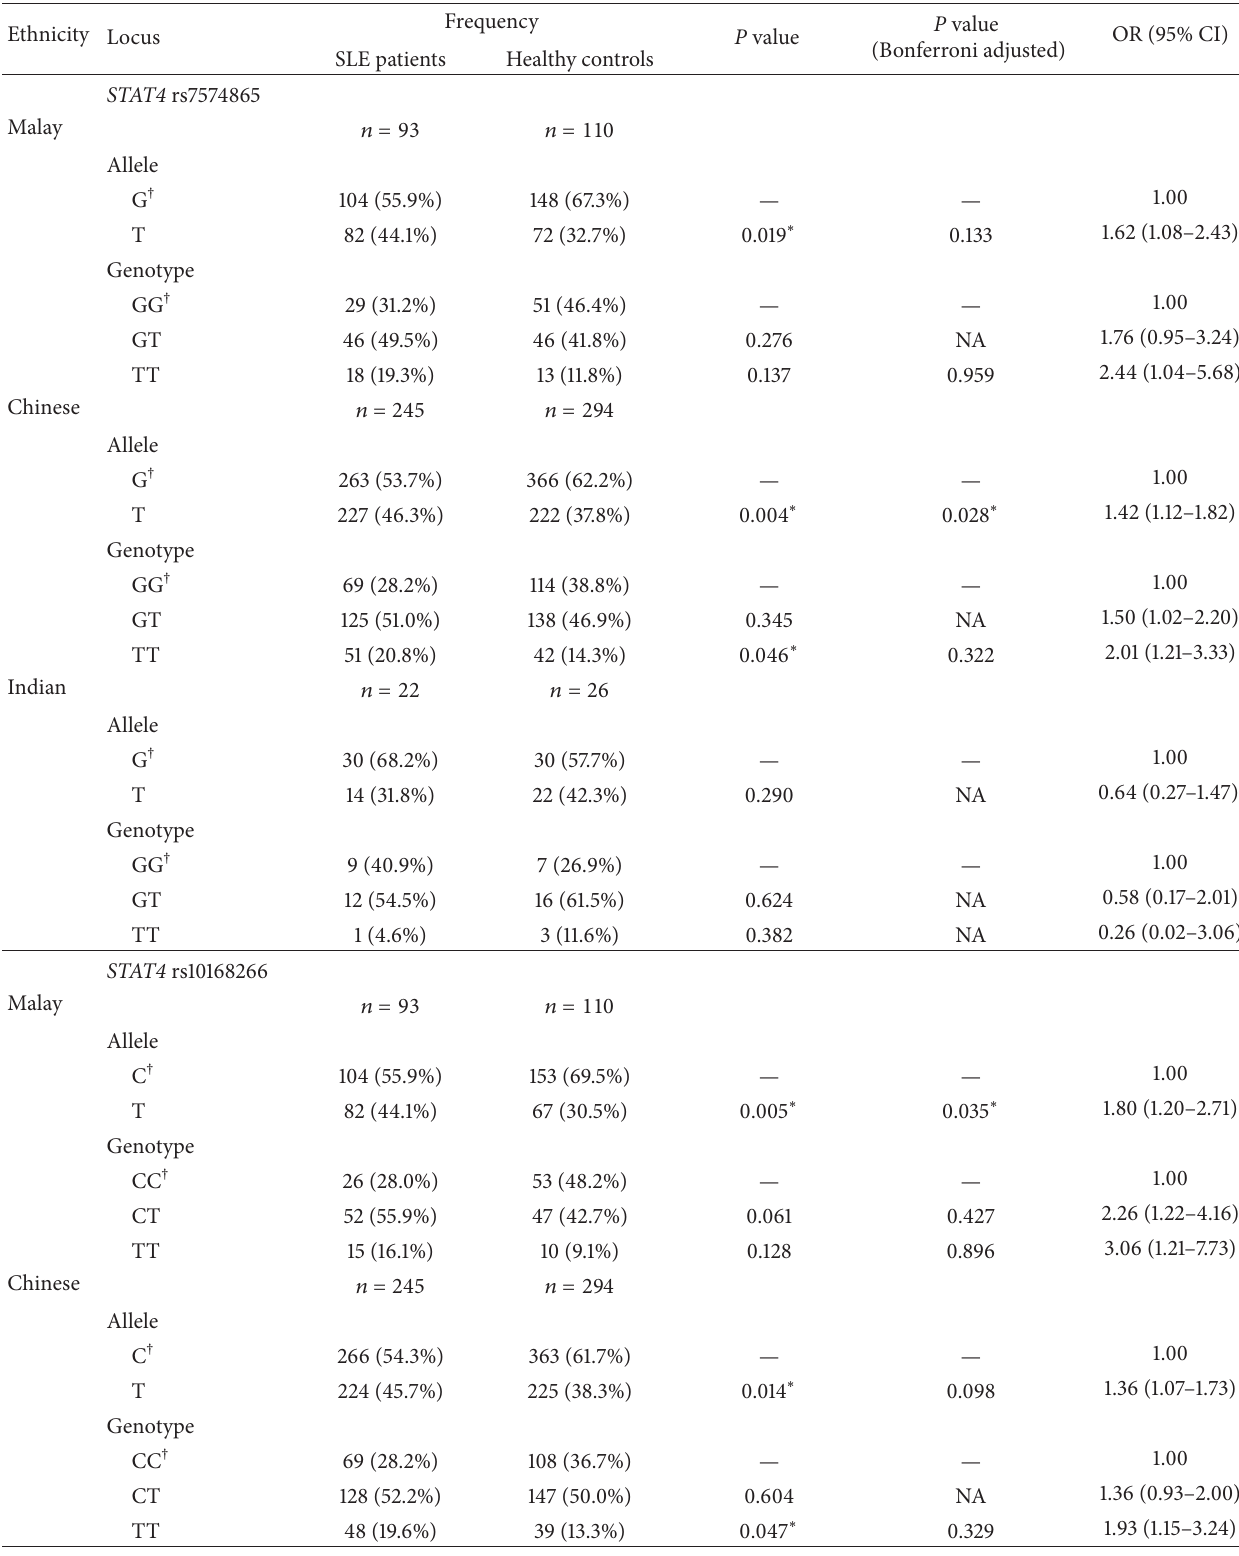
Table 4: Frequencies of alleles and genotypes for STAT4 rs7574865 and rs10168266, and TNFAIP3 rs2230926 in SLE patients and healthy control subjects of each